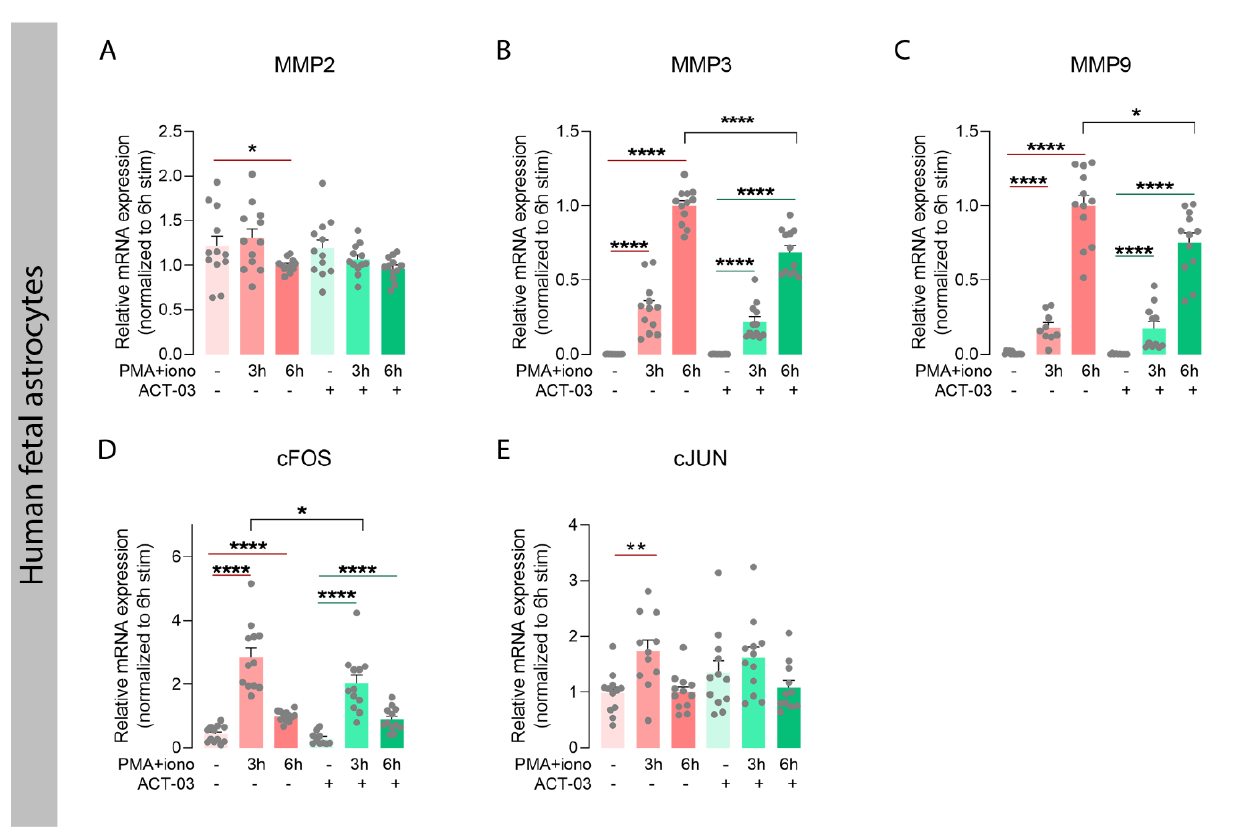
Figure 6. Attenuation of metalloproteinases and inflammatory transcription factors by ACT-03 in astrocytes. ( A – E ) Relative mRNA expression of human fetal astrocytes ( n = 4 donors in experimental triplicates) measured by quantitative PCR showed less matrix metalloproteinase 2 (MMP2) and higher expression of MMP3, MMP9, and subunits of the transcription factor activator protein 1, cFOS, and cJUN, after 3 and/or 6 h stimulation with 50 nM phorbol myristate acetate (PMA) and 1000 nM ionomycin (iono) ( p < 0.01). Simultaneous treatment with 150 µ M ACT-03 resulted in lower mRNA expression of MMP3, MMP9, and the cFOS gene compared to stimulation only ( p < 0.05). Bar graphs display mean + SEM, with individual values as dots; *, p < 0.05; **, p < 0.01; ****, p < 0.0001. Within treatment comparisons indicated with red/green lines. Between treatment comparisons indicated with hooked black lines.